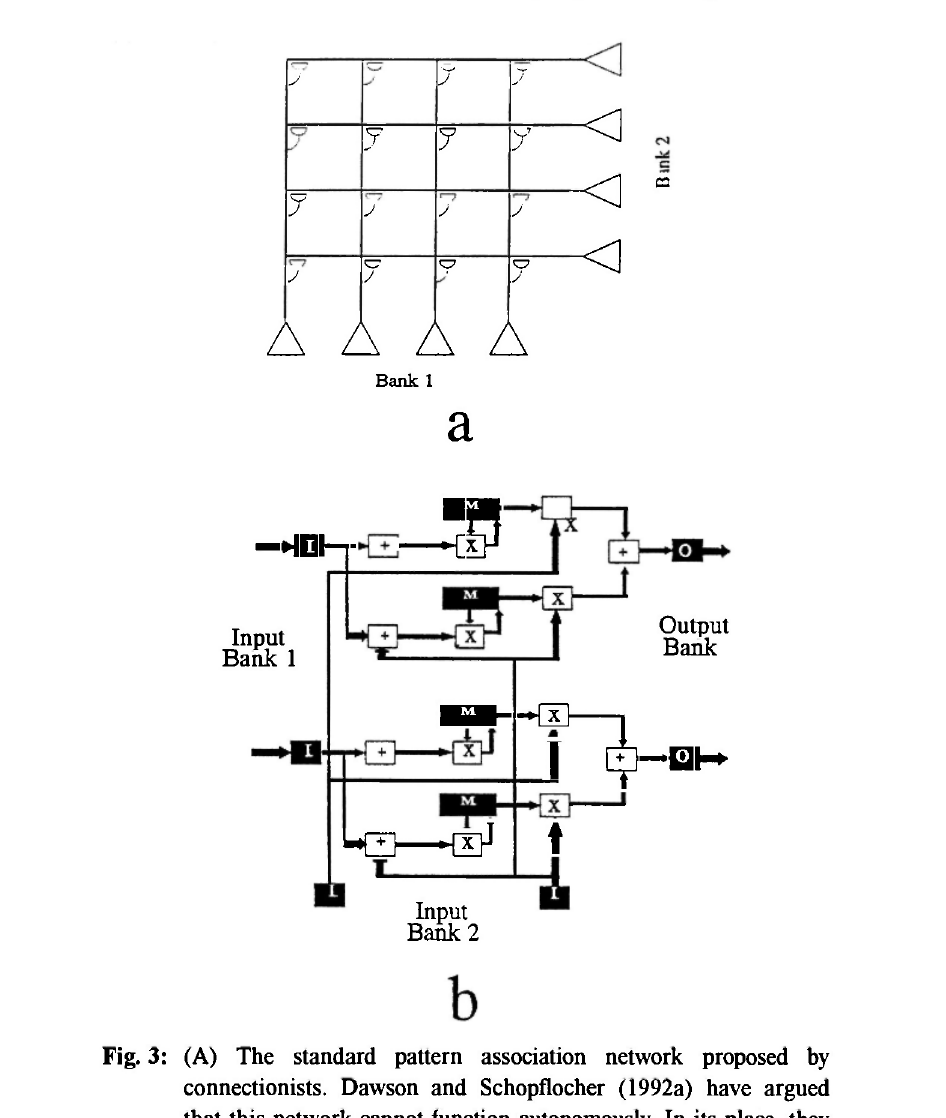
Fig. 3: (A) The standard pattern association network proposed by connectionists. Dawson and Schopflocher (1992a) have argued that this network cannot function autonomously. In its place, they propose a network constructed from an elaborated functional architecture. (B) A small version of the Dawson and Schopflocher network. Units marked with "I" are input units, with "O" are output units, and with "M" are memory units. Operators marked with "+" compute the sum of their inputs; operators marked with "X" compute the product of their inputs. Connections in this architecture have fixed weights equal to